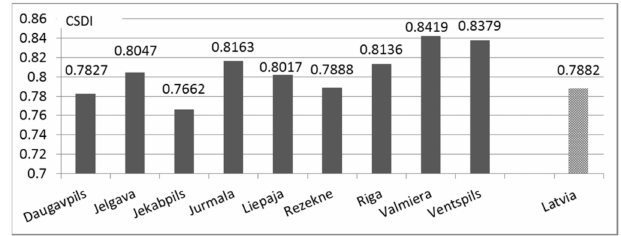
Figure 8. CSDI for cities of Latvia. Developed by